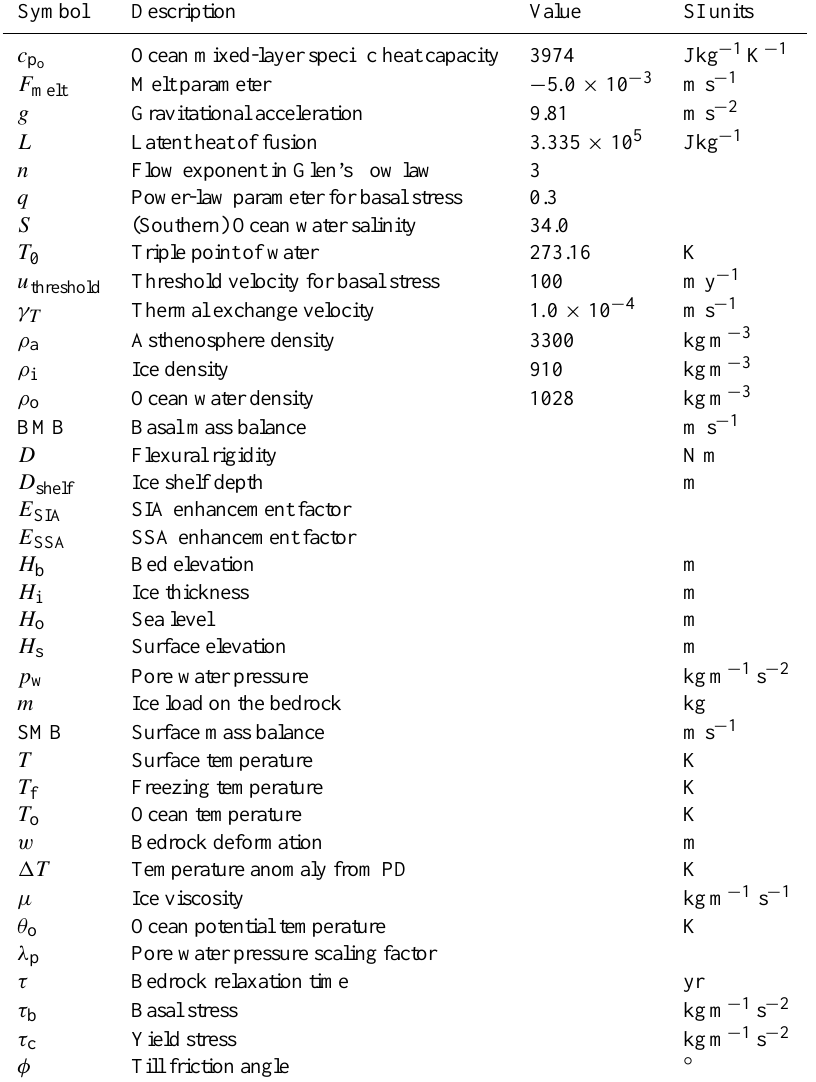
Table 1. List of used symbols, their descriptions and values and SI units when